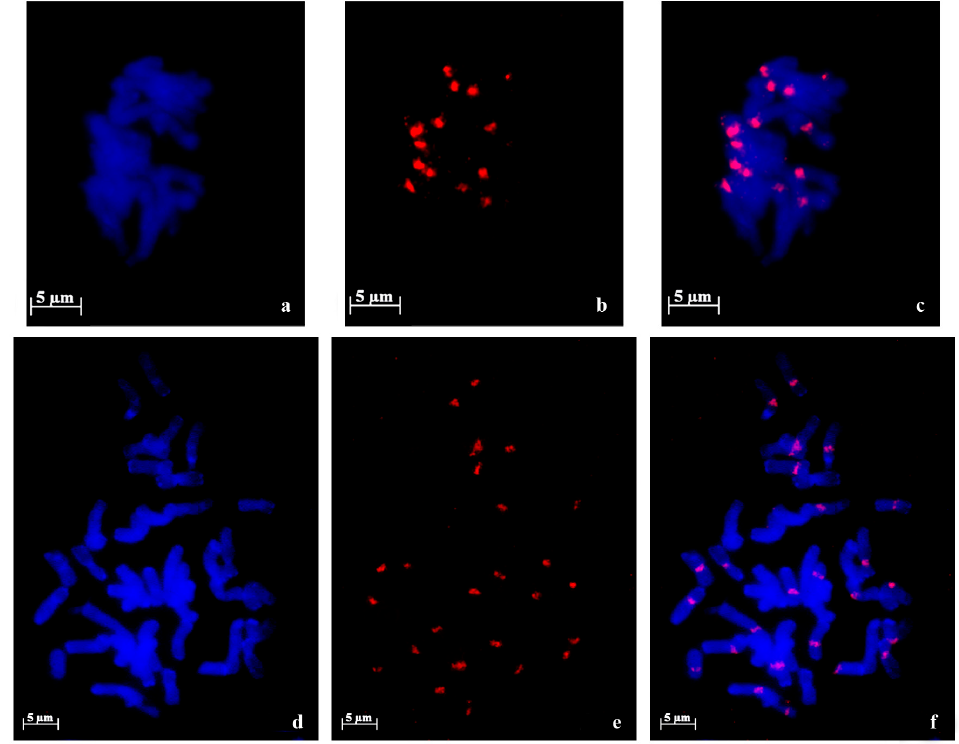
Figure 5. Centromeric sequence fluorescent in situ hybridization (red signals) in metaphase cells. Metaphase cells of A. strigosa ( a – c ); and A. sterilis ( d – f ) with DAPI staining ( a , d ), FISH with centromeric probe (Accession Number KM948610) ( b , e ) and merge of both fluorescent signals ( c , f ).